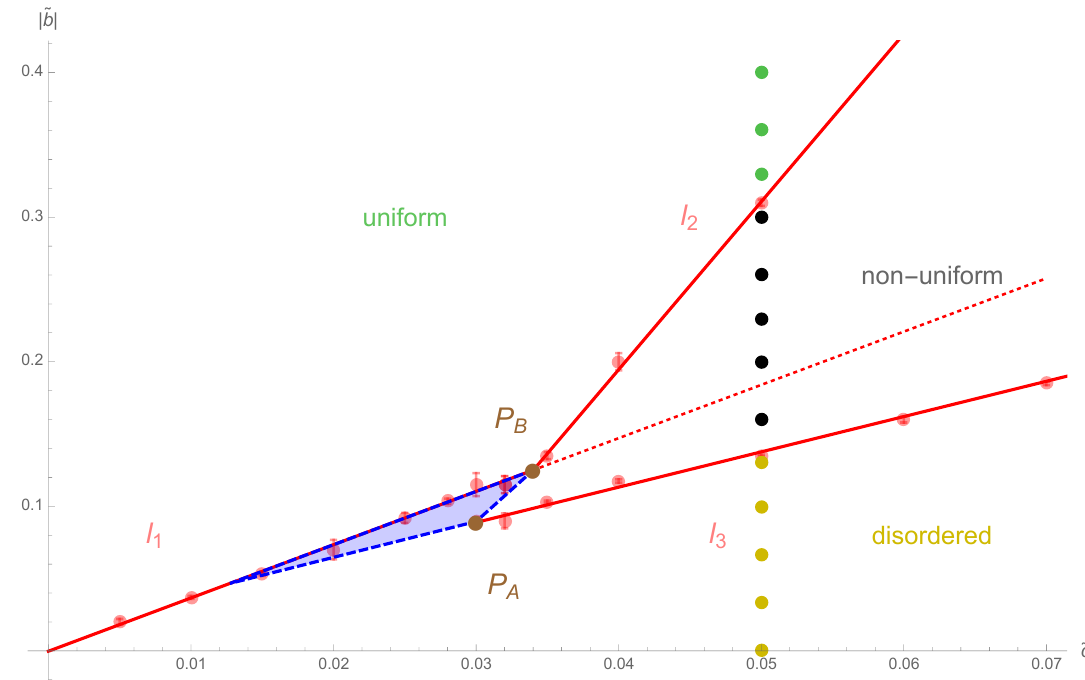
Figure 3 . The phase diagram for N = 64. Red lines are the (cid:12)ts of measured phase transitions, which are denoted by points with barely visible error bars. P B denotes the point where l 1 bends into l 2 , P A denotes the point where l 3 emerges. The position of the triple point can be estimated to either lay in the blue triangle or, as a cruder estimate, just between these two points. The phase transitions